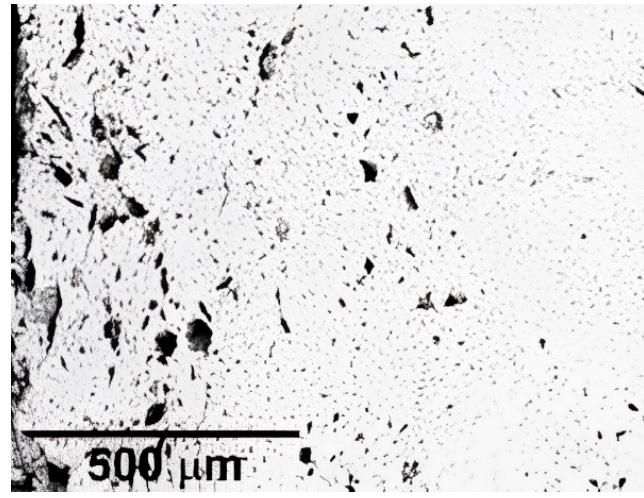
Figure 15. Layered FGP with graded porosity (Reprinted from Ref. [91], copyright (2005), with the kind permission of Elsevier Ltd.). Table 5. Physical and electrical properties of the samples at different porosity (Reprinted from Ref. [91], copyright (2005), with the kind permission of Elsevier Ltd.).